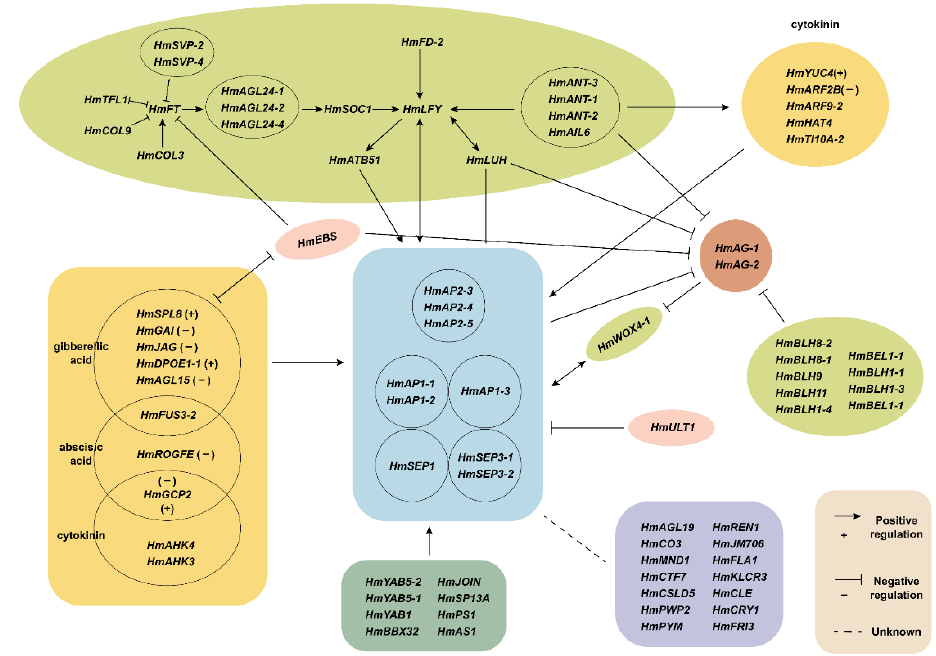
Figure 10. The hypothetical model of gene regulatory network for the development of decorative floret sepals in H. macrophylla .